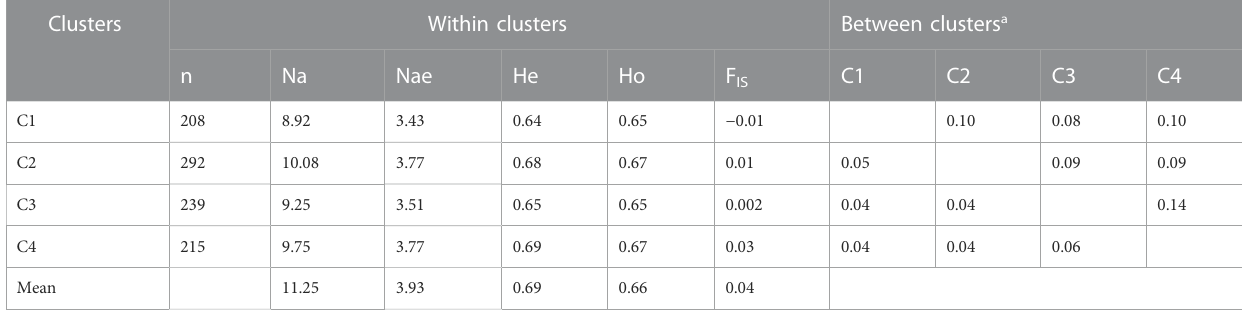
TABLE 6 Genetic diversity parameters of the inferred clusters from the Beninese goat population ( N = 954).